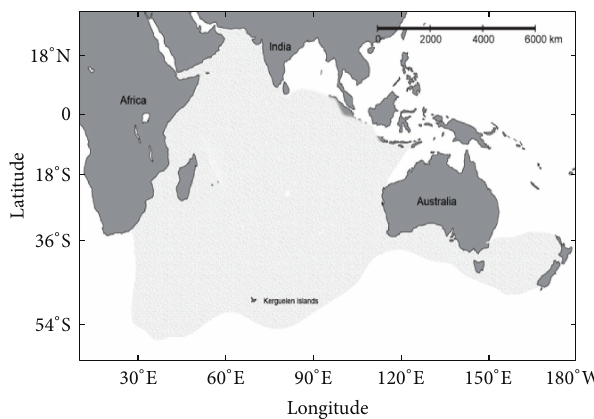
Figure1:DistributionofpygmybluewhalepopulationintheIndian Ocean (redrawn from [1] and